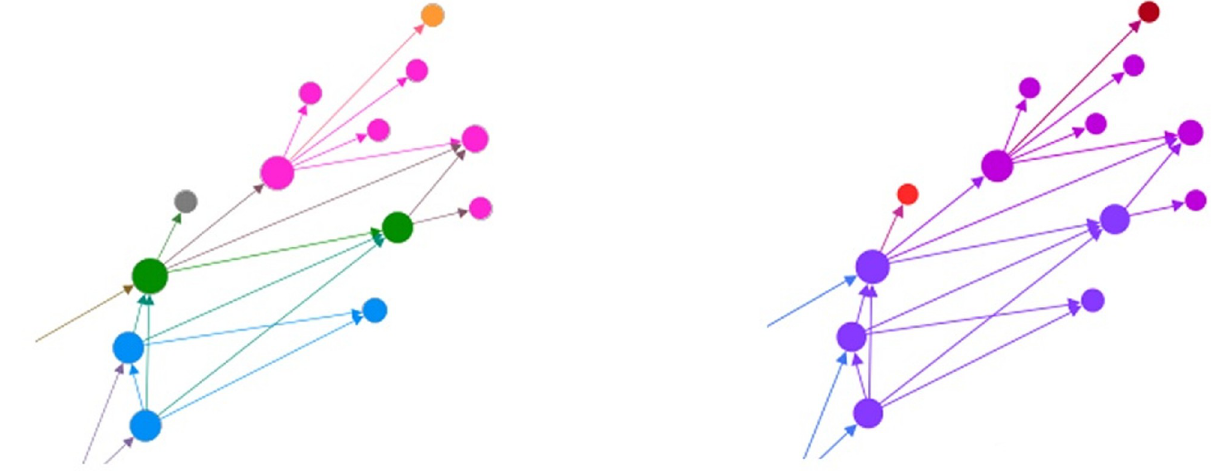
Fig 3. Direct comparison of devices in upper Da Vinci Si predicate branch.